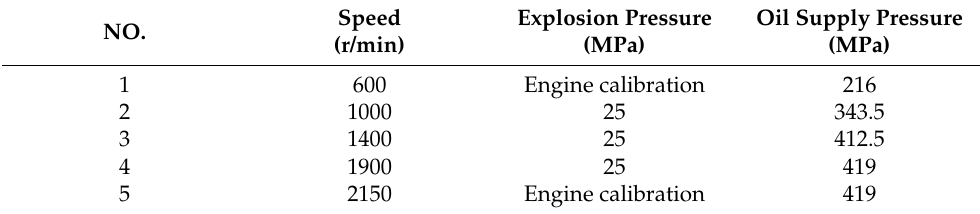
Table 8. Working conditions of simulation.